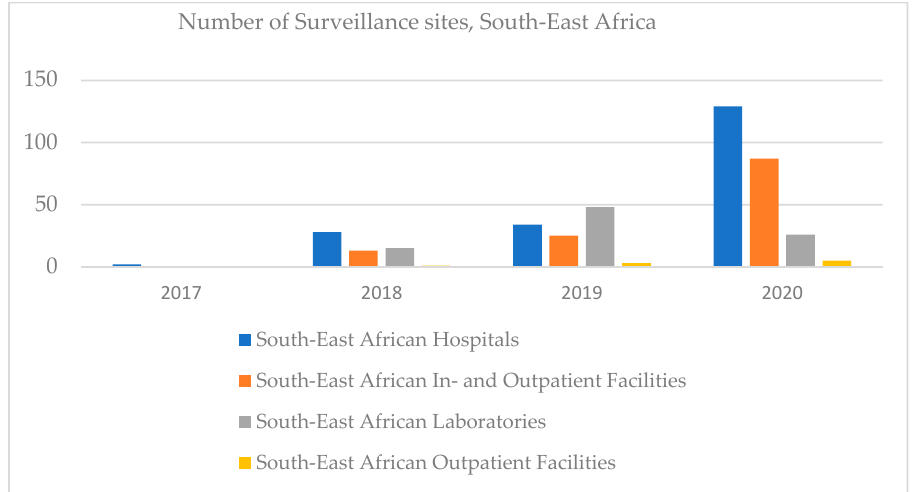
Figure 8. Number of surveillance sites, South-East Africa, 2017–2020. In the Western Pacific, the number of in- and outpatient hospitals has increased over time, the number of outpatient facilities has stagnated, and there are no on-board clinics registered (Figure 9).